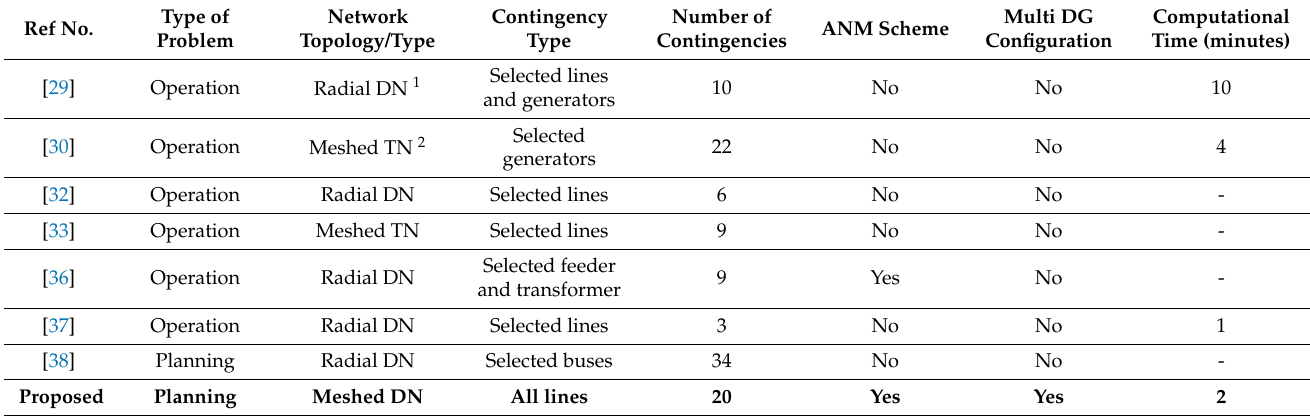
Table 2. Comparison of the proposed method for SCOPF with existing